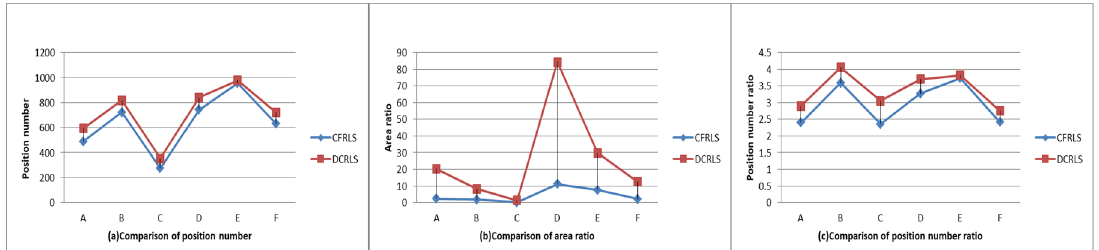
Figure 8. Comparison of position profile data.